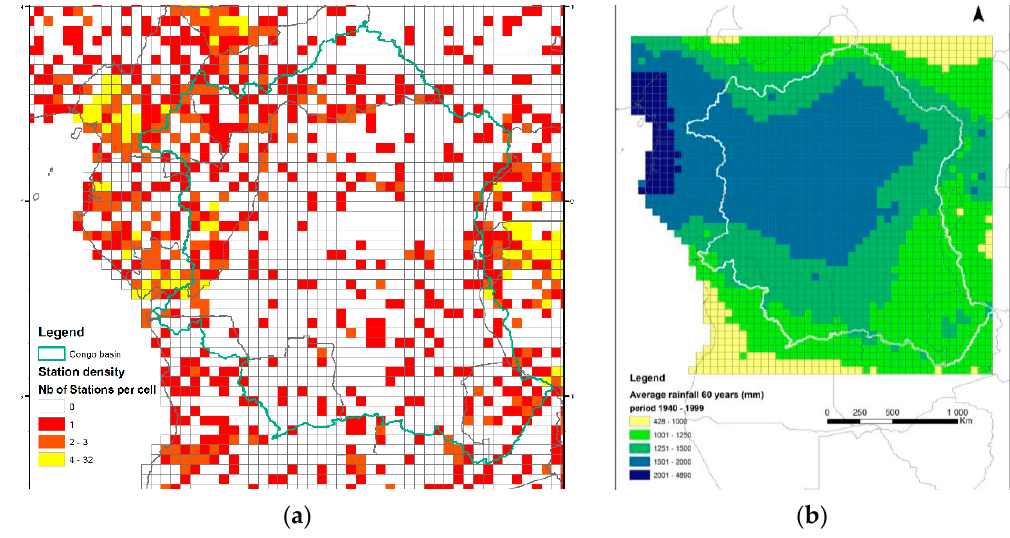
Figure 2. ( a ) Density of observed rainfall stations over the Congo River Basin area [18], ( b ) Inter ‐ annual averaged rainfall over the Congo River Basin, period 1940–1999, from the SIEREM database [6,20].